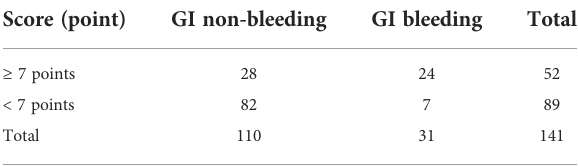
TABLE 5 Internal validation of scoring model.